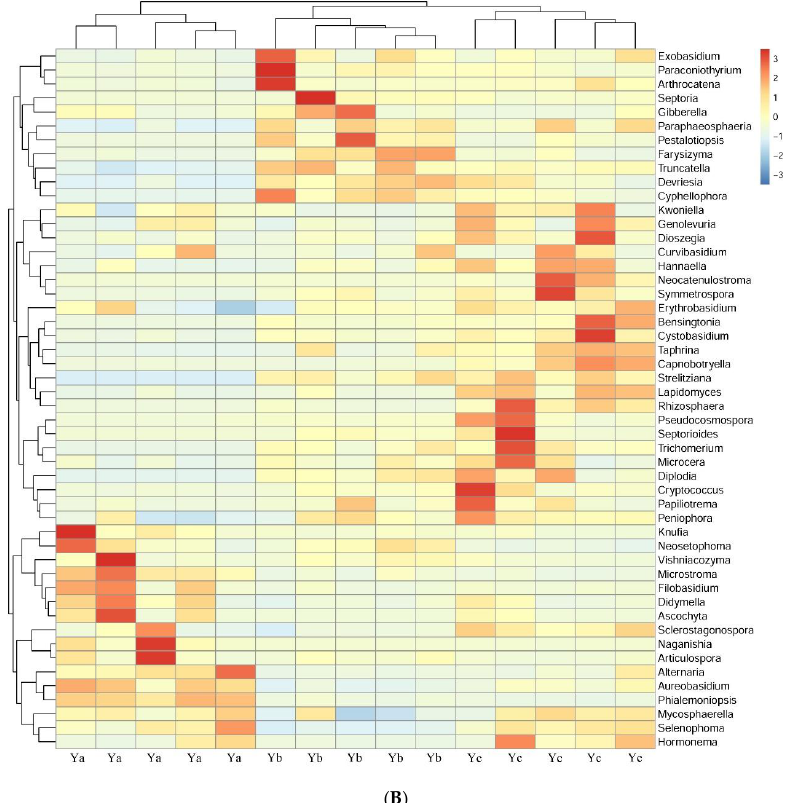
Figure 4. Heatmaps of the top 50 phyllosphere bacterial ( A ) and fungal ( B ) communities at the genus level. The scale “−3 to +3 ” refers to the relative abundance of the corresponding taxonomic unit in each sample/group of the grouping scheme. Ya: healthy Pinus tabuliformis trees; Yb: diseased P. tabu- liformis trees at an early stage of B. xylophilus infection; Yc: diseased P. tabuliformis trees in the last stage.